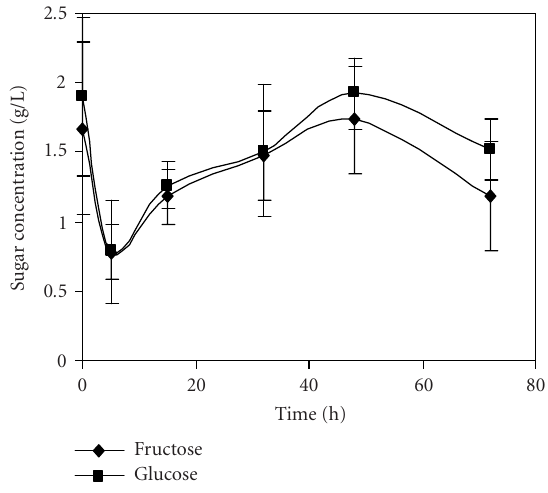
Figure 6. Evolution of sugar concentration in the pomegranate juice obtained by the squeezing of fruit halves with an electric lemon squeezer and stored for 72 hours at 4 ◦ C. Bars represent standard deviation of 4 replications.